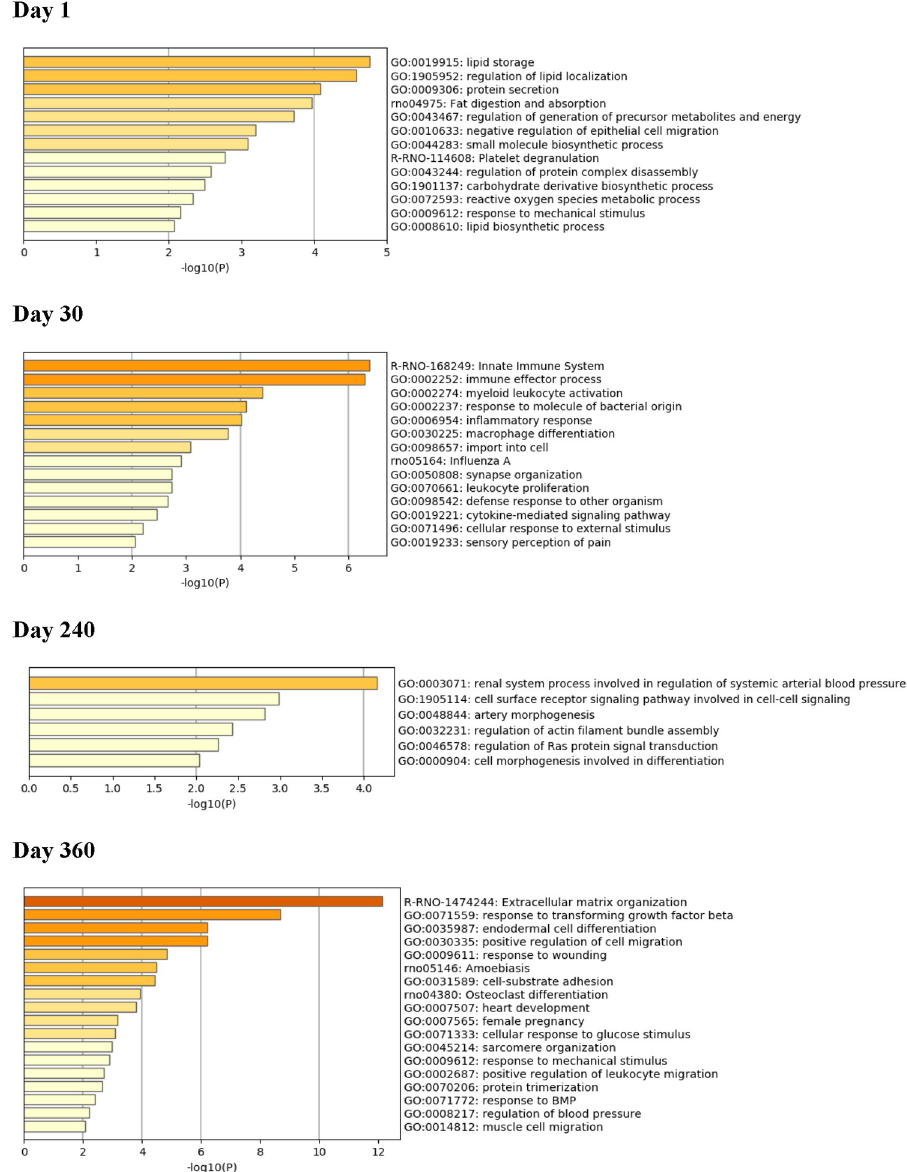
Fig 15. Enrichment analysis for up-regulated genes in hearts. Functional gene set enrichment analysis (GSEA) of top up-regulated genes was performed for tissues collected at Days 1, 30, 240, and 360 post-exposures. The X-axis is the negative log-transformed p-value of the enriched terms. The darker the color, the more statistically significant the enriched term (pathways, GO terms, etc.). Groups of rats exposed to air (na ï ve, n = 6/each timepoint group) or ISO (n = 5/Day 1 group, and n = 6/Day 30, 240, and 360 groups) were